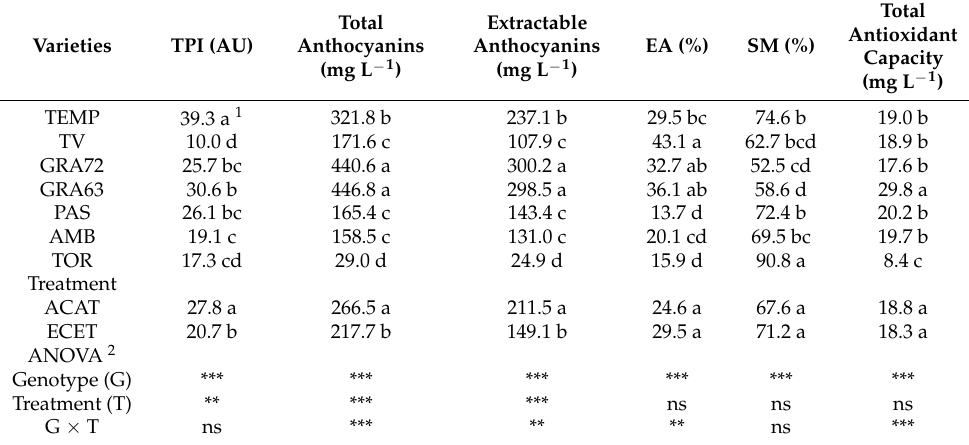
1 Values represent means. Within columns, means followed by the same letter do not differ significantly ( p ≥ 0.05) according to Duncan’s test as affected by the main factors genotype (G) (n = 8–12), treatment (T) (n = 34) and their interaction (G × T). 2 Significance of the analysis of variance (ANOVA): ** p < 0.01; *** p < 0.001; ns, not significant ( p ≥ 0.05). TPI, total polyphenol index; EA, cellular extractability of anthocyanins; SM, seed maturity; AU, absorbance